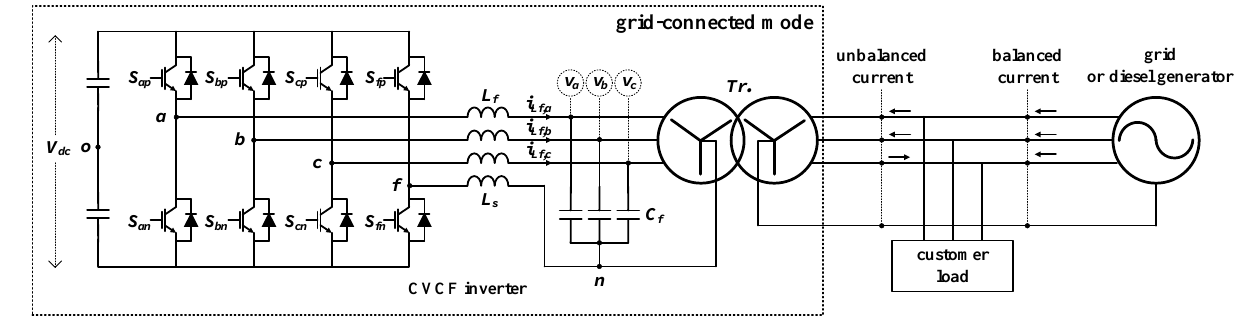
Figure 9. Operation condition of grid-connected mode.